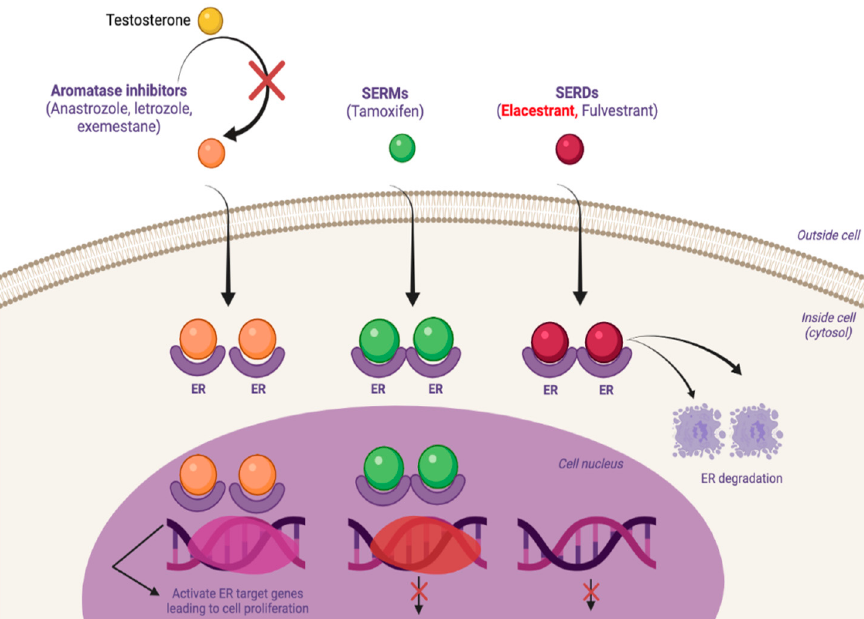
Figure 1. Mechanism of action of the different ET: aromatase inhibitors, SERMs and SERDs. ER and its activity modulated by AI, SERMs and SERDs: AI block estrogen production by inhibiting the aromatization of androgens to estrogens. SERMs (tamoxifen) competitively inhibit the binding of estrogen to ER. SERDs produce a reduction of SERD-bound ER ability to translocate to the nucleus, inhibiting transcription of ER-regulated genes. SERD-bound ER undergoes degradation as a consequence of impaired mobility.